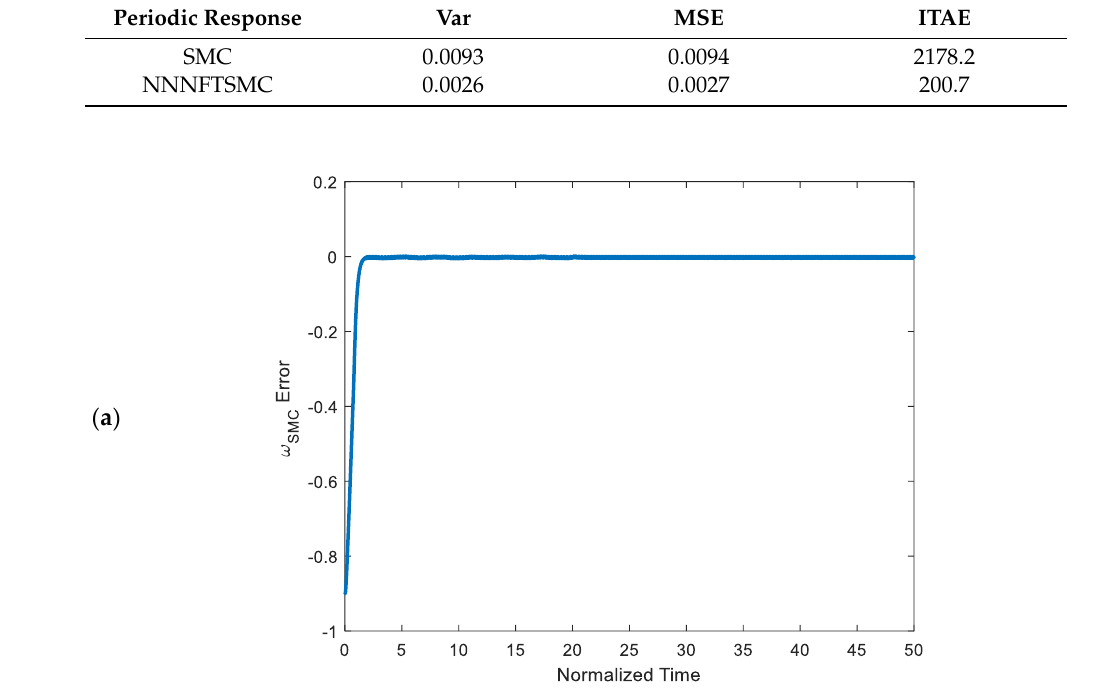
Table 1. Results of SMC and NNNFTSMC for periodic response.